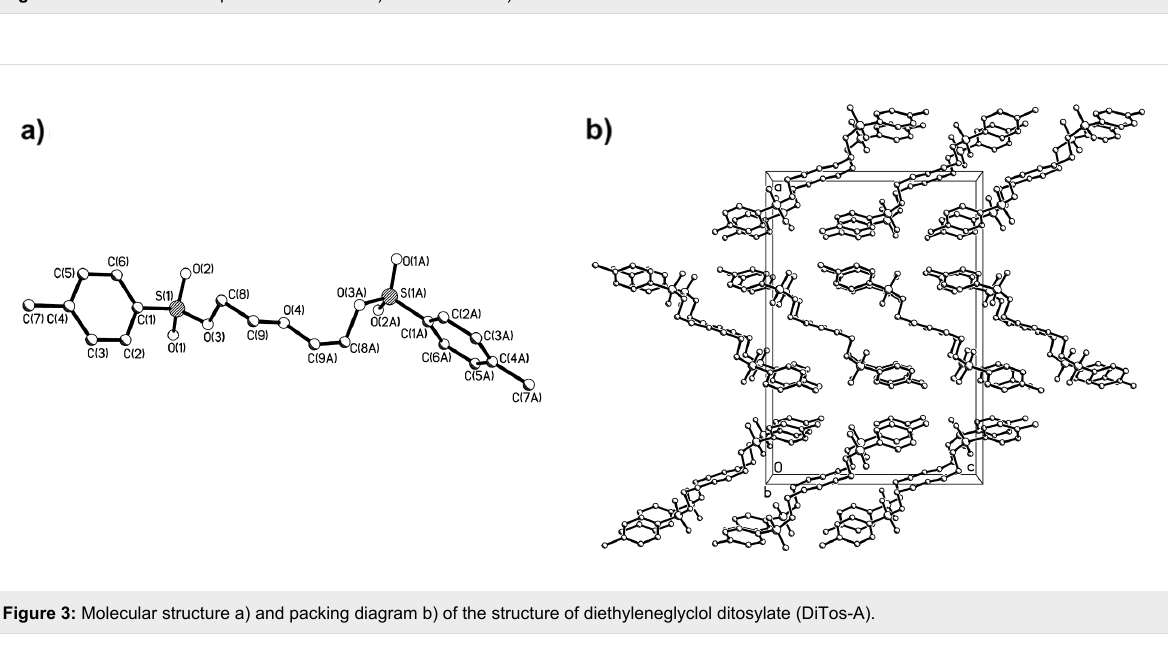
Figure 2: MALDI-TOF MS spectra of TetraTos a) and HexaTos b) Matrix: dithranol.